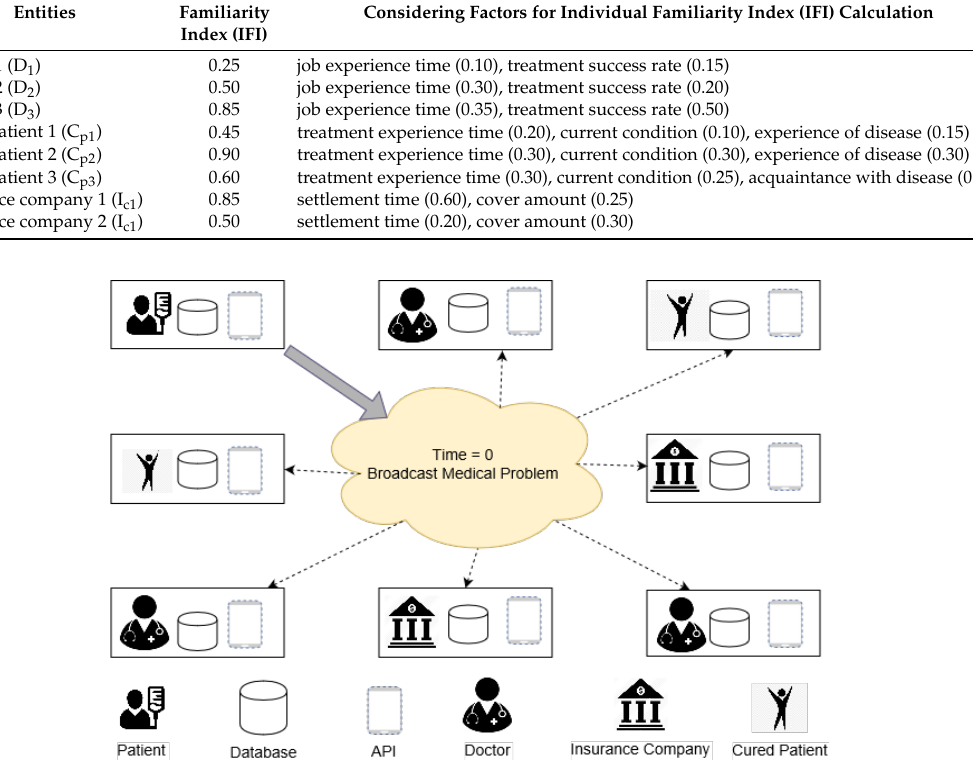
Figure 8. At time 0: Patient broadcasts medical problem to other entities. Appl. Sci. 2019 , 9 , x